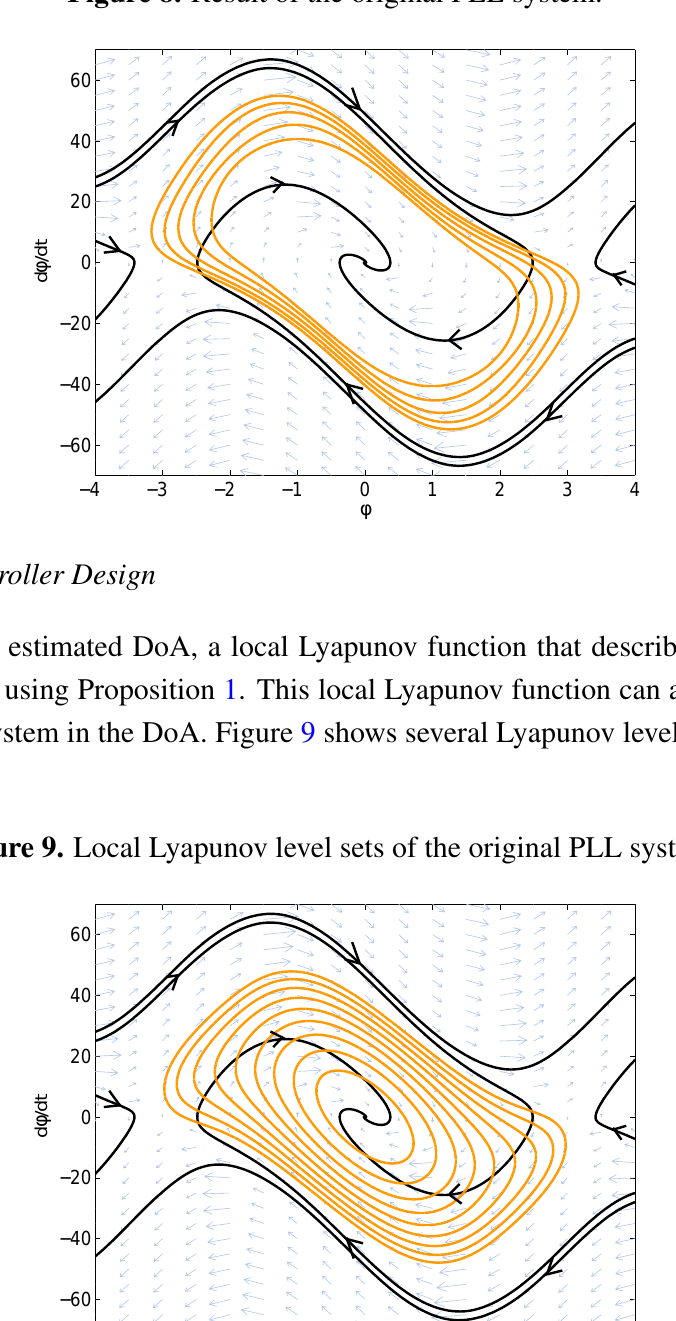
Figure 8. Result of the original PLL system.